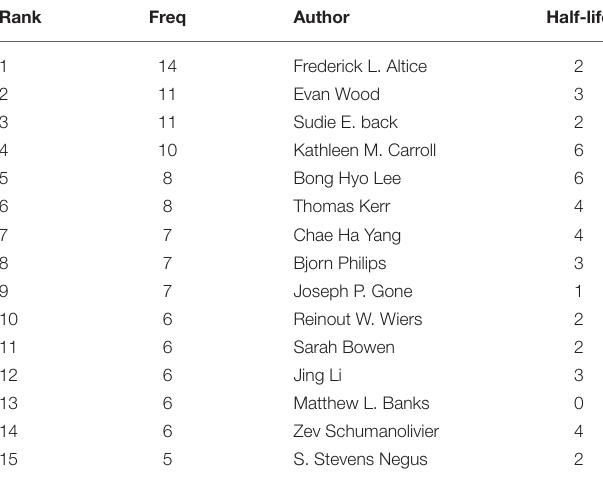
TABLE 1 | Top 15 countries/regions related to complementary and alternative medicine for substance use disorders. Rank Freq